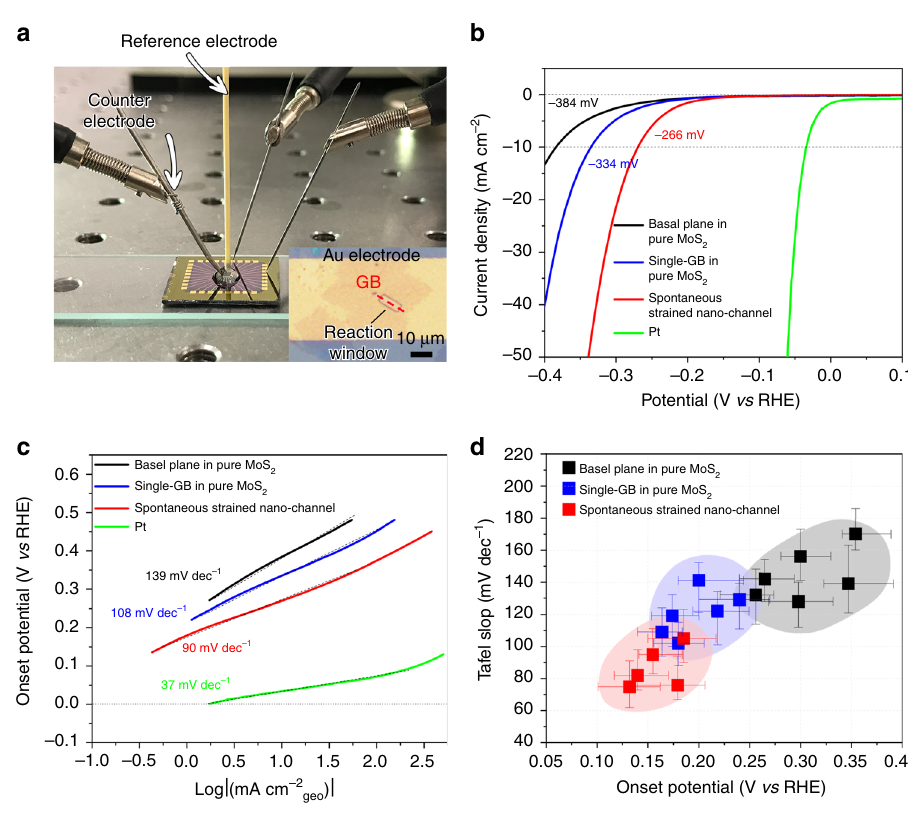
Fig. 7 HER activity of MoS 2 single GB in nano-channel. a Photograph of micro-electrochemical cell. Inset: device with a micro-size reaction window at the spontaneous strained nano-channel. The hydrogen evolution reaction (HER) only occurs within the reaction window, and the rest of the areas are passivated by electrochemically inert PMMA fi lm. b – c Polarization curves of the current density ( b ) and the corresponding Tafel plots ( c ) of the devices for spontaneous strained MoS 2 nano-channel, single GB, and basal plane in pure MoS 2 , respectively. d Statistical HER results obtained from dozens of micro- electrochemical devices. The error bars de fi ne the data statistical range of multiple measurements for each micro-electrochemical